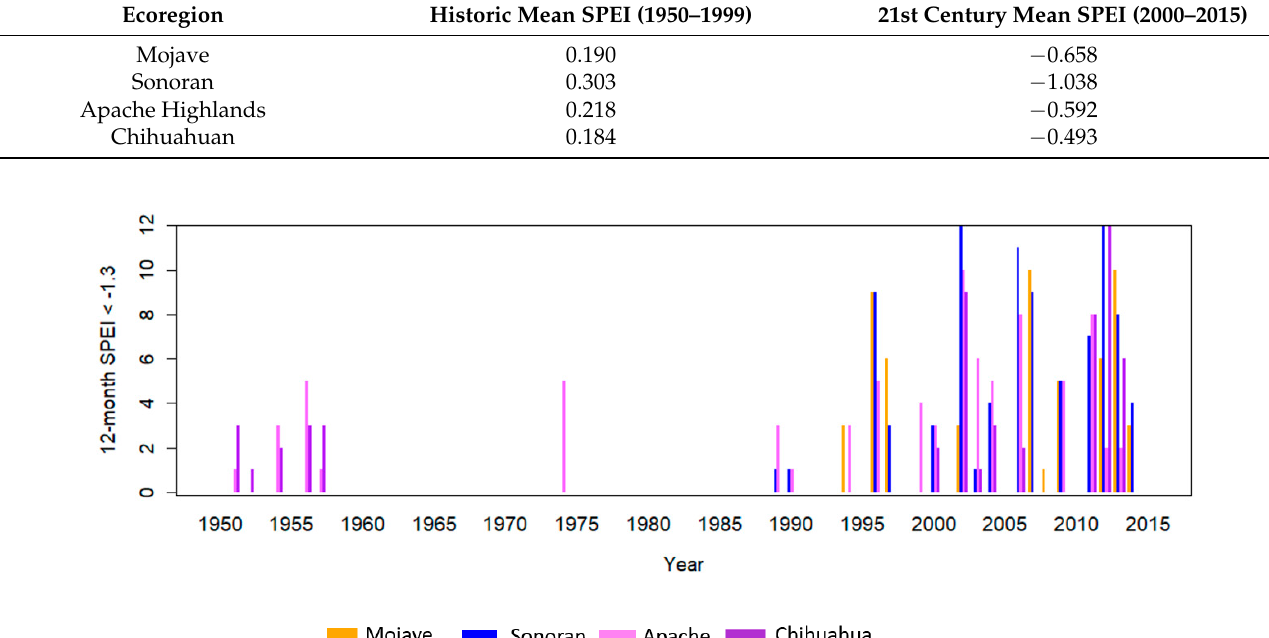
Figure 6. The number of months per year in which 12-month SPEI values indicated severe drought are shown for each year from 1950 to 2015 for all four ecoregions. The recent years focused on this Scheme 2000. had more severe drought compared to the preceding 50 years [31]. There is no classification for the SPEI values in the U.S. Drought Monitor. Therefore, similar to Barnes et al. [7] we used the drought severity classification of Standardized Precipitation Index (SPI) to classify SPEI used by U.S. Drought Monitor (https://droughtmonitor.unl.edu/About/AbouttheData/DroughtClassification.aspx (accessed on 14 March 2021)).